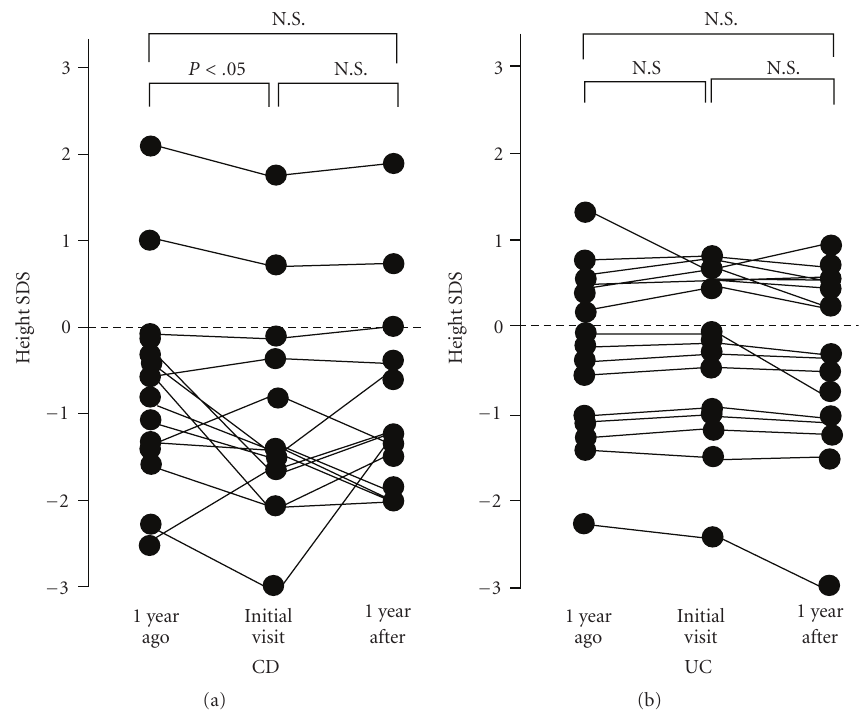
Figure 2: Changes in height SDS in children with CD and those with UC.